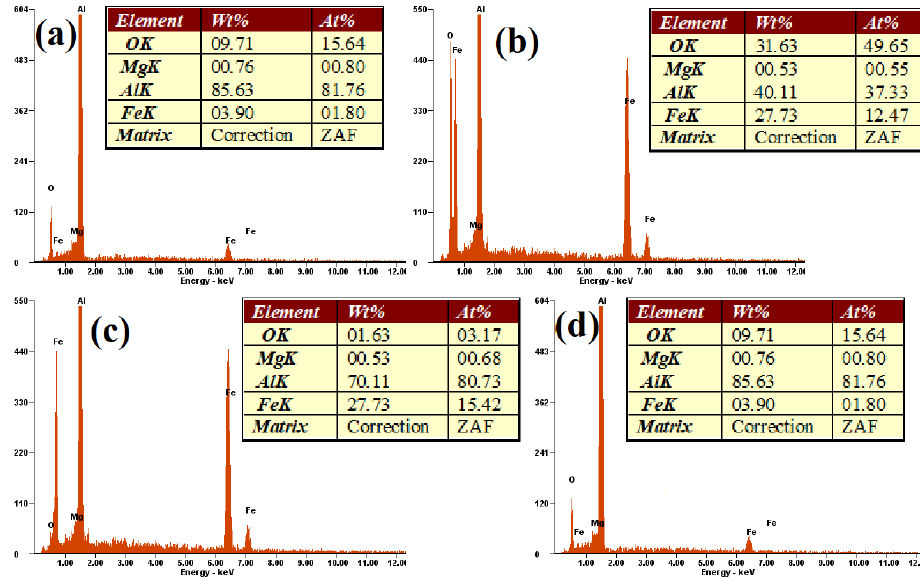
Figure 3. The EDS spectrum of Al-15Fe 3 O 4 composition: ( a ) aluminum, ( b ) Fe 3 O 4 , ( c ) Al 3 Fe, and ( d ) Al 2 O 3 . The FESEM micrograph, in different magnifications for Al-30Fe 3 O 4 -20SiC, is also shown in